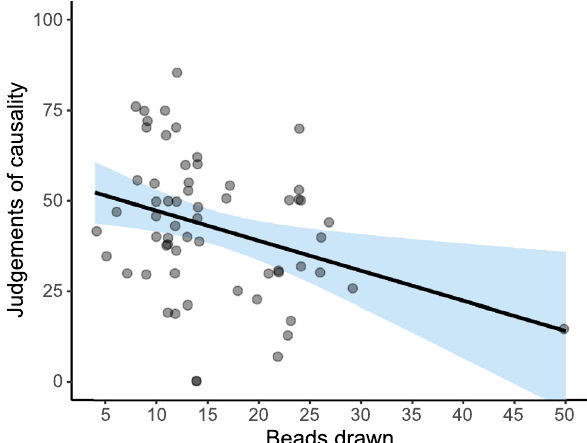
Figure 9. Scatterplot depicting judgements of causality as a function of JtC measure in Study 2. The scatterplot shows causal judgements (vertical axis), and the number of beads drawn in the Beads task (horizontal axis), which assesses the JtC bias. The line fitting the data points displays a negative slope, indicating that the participants who required more information in the Beads task were more accurate in their causal judgements. We added horizontal jitter to the data points to prevent overplotting.